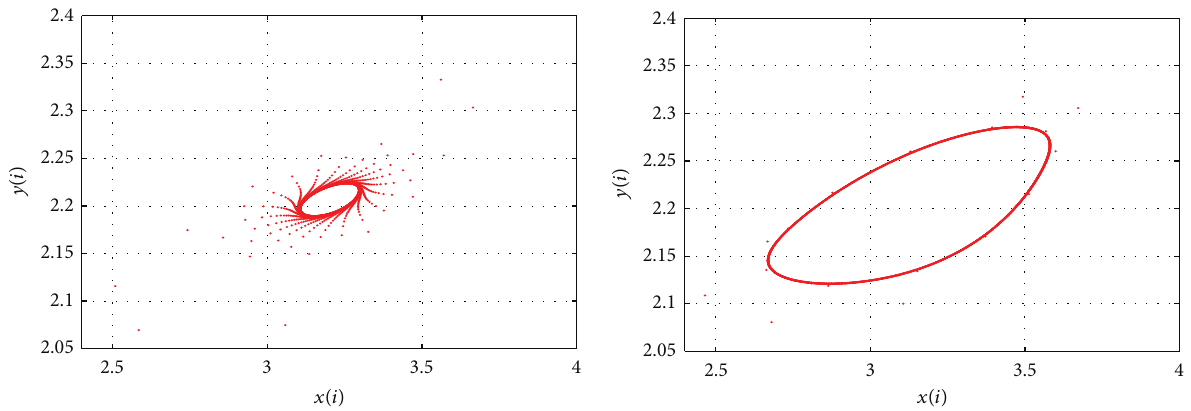
Figure 11: The portraits for several values of 𝐴 1 = 0.03 , 𝛿 = 4.885 , and 𝛿 = 5